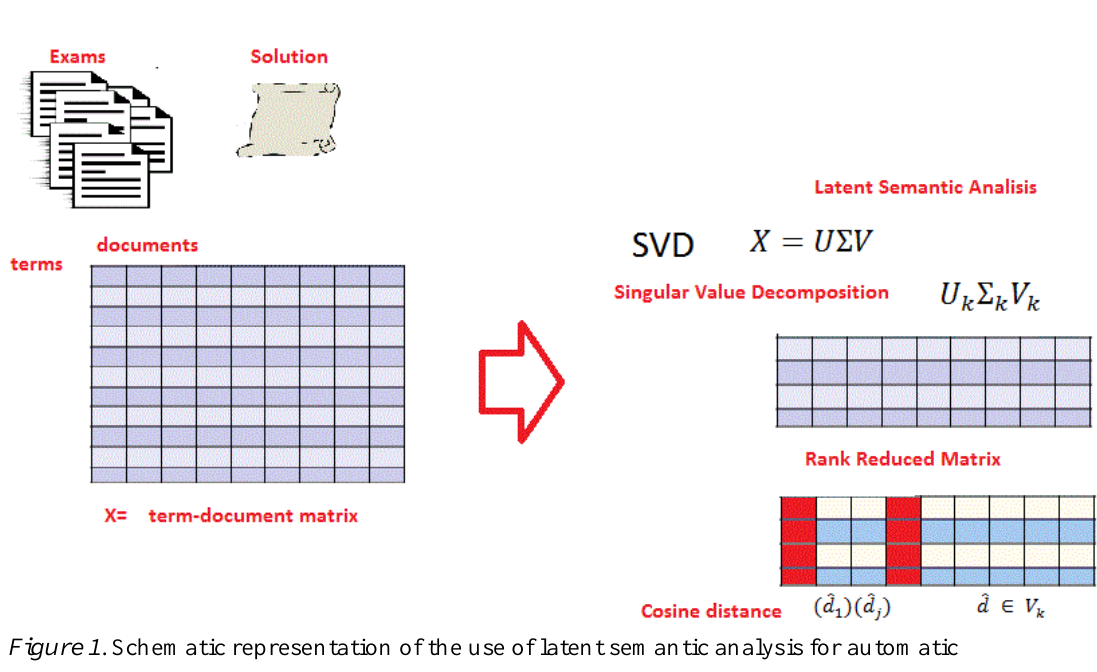
Figure 1 . Schematic representation of the use of latent semantic analysis for automatic essay scoring is the term-document matrix and is the singular value decomposition of the matrix, which allows computing a rank reduction matrix over which the cosine distance among documents is